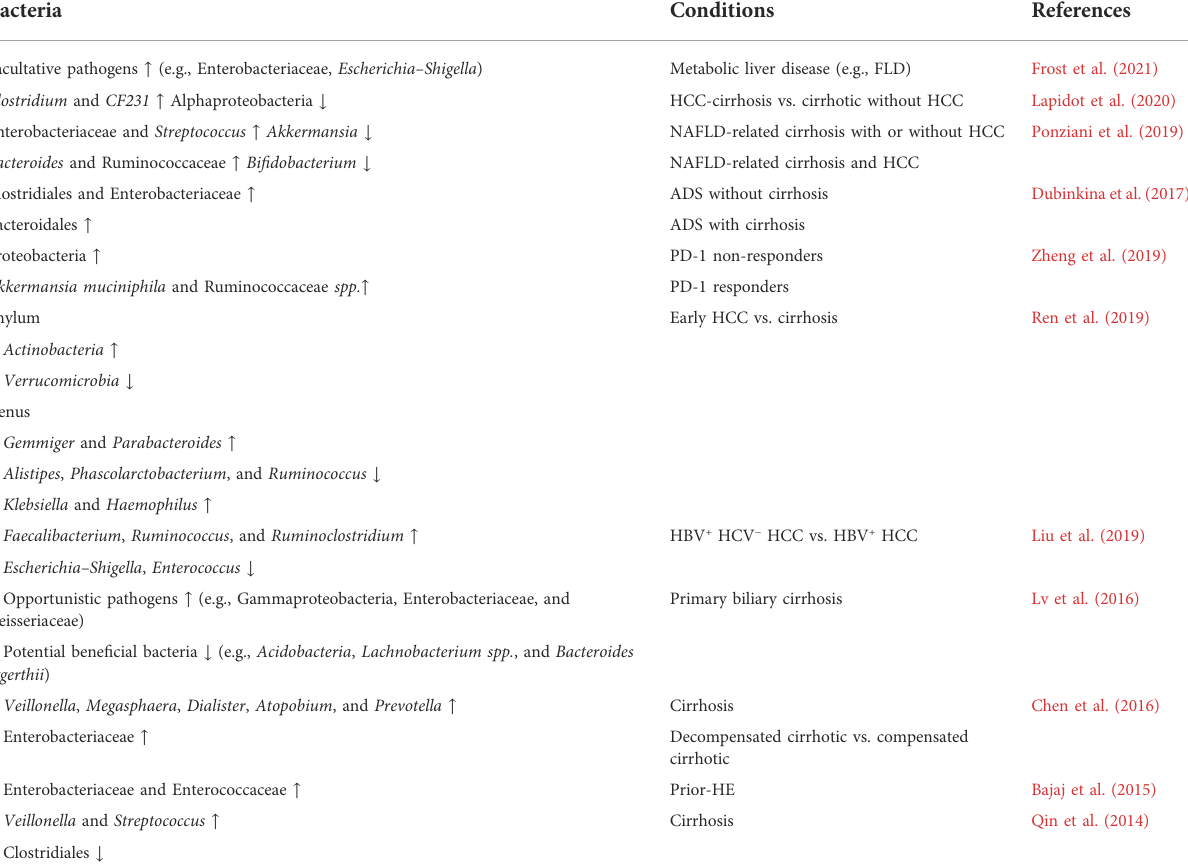
TABLE 2 Dysbiosis in patients with HCC and HCC-related liver